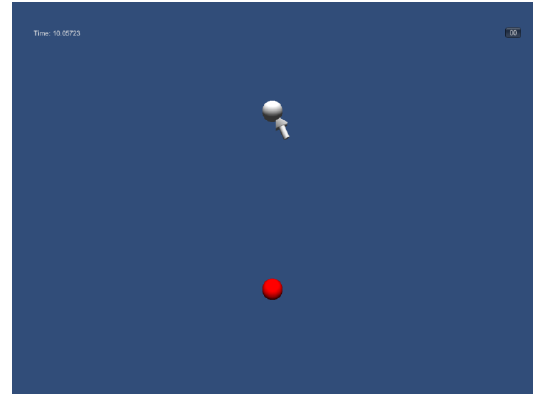
In a sequence from Figure 4, participants clicked the red ball and the ball color changed into white (top) then, the next ball in red color (bottom) appears and the participant should click that red ball until all balls are